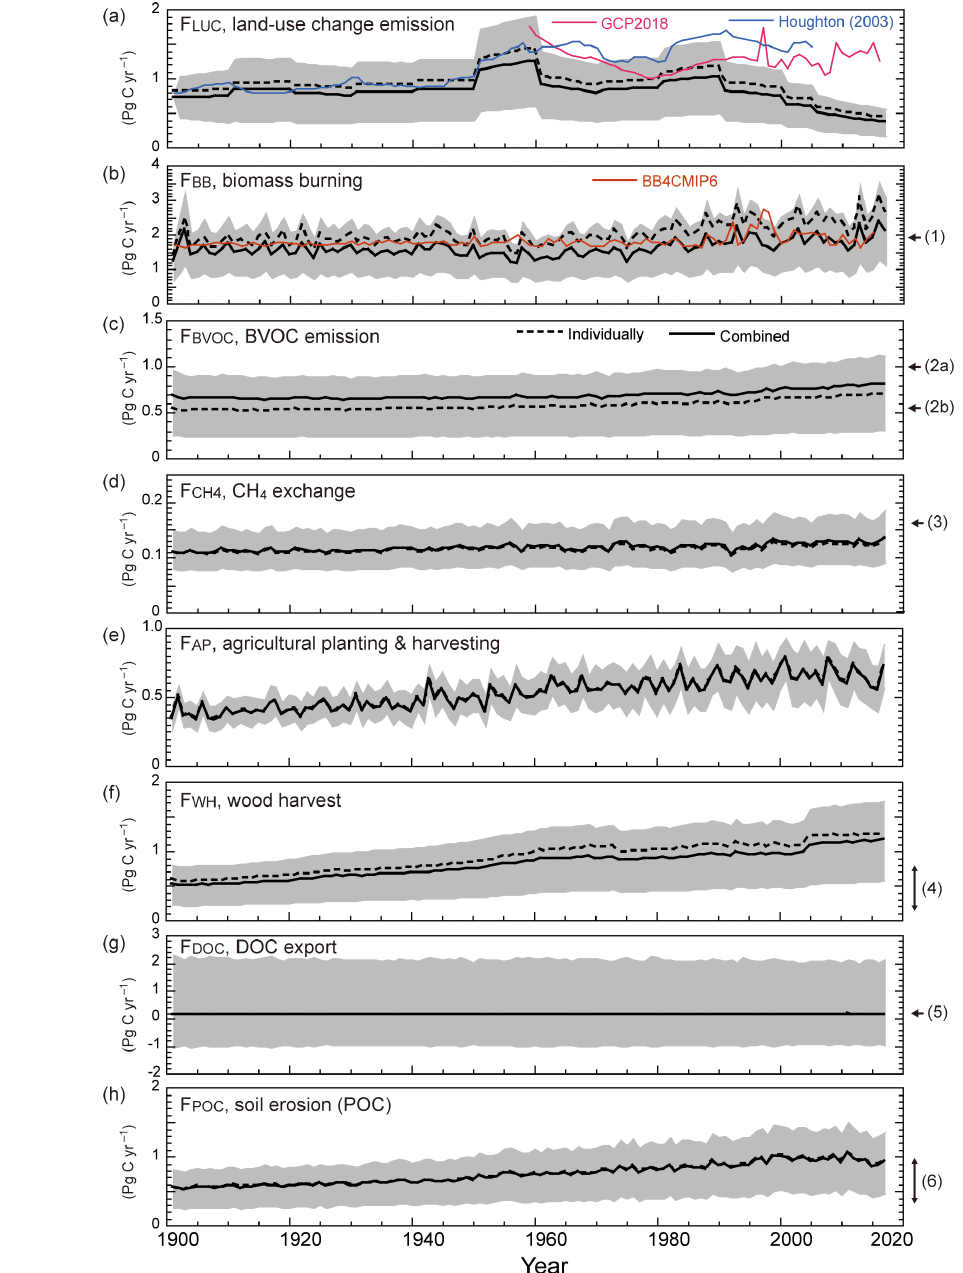
Figure 5. Time series of minor carbon flows simulated by the VISIT model and previous studies. Dashed lines are results of individually simulated flows, and solid lines are results of the EX ALL simulated, and shading shows the 95% confidence interval for the EX ALL result obtained from ensemble simulations (Fig. S2). Blue and red lines in panel (a) show data of the Global Carbon Project (GCP2018) and Houghton (2003). The orange line in panel (b) shows data of BB4CMIP6 (van Marle et al., 2017). Arrows indicate the values of (1) biomass burning emission by Randerson et al. (2012), (2a) total BVOC and (2b) isoprene emissions by Guenther et al. (2012), (3) wetland and paddy methane emission by Saunois et al. (2017), (4) wood harvest by Arneth et al. (2017), (5) DOC export by Dai et al. (2012), and (6) soil erosion by Chappell et al.